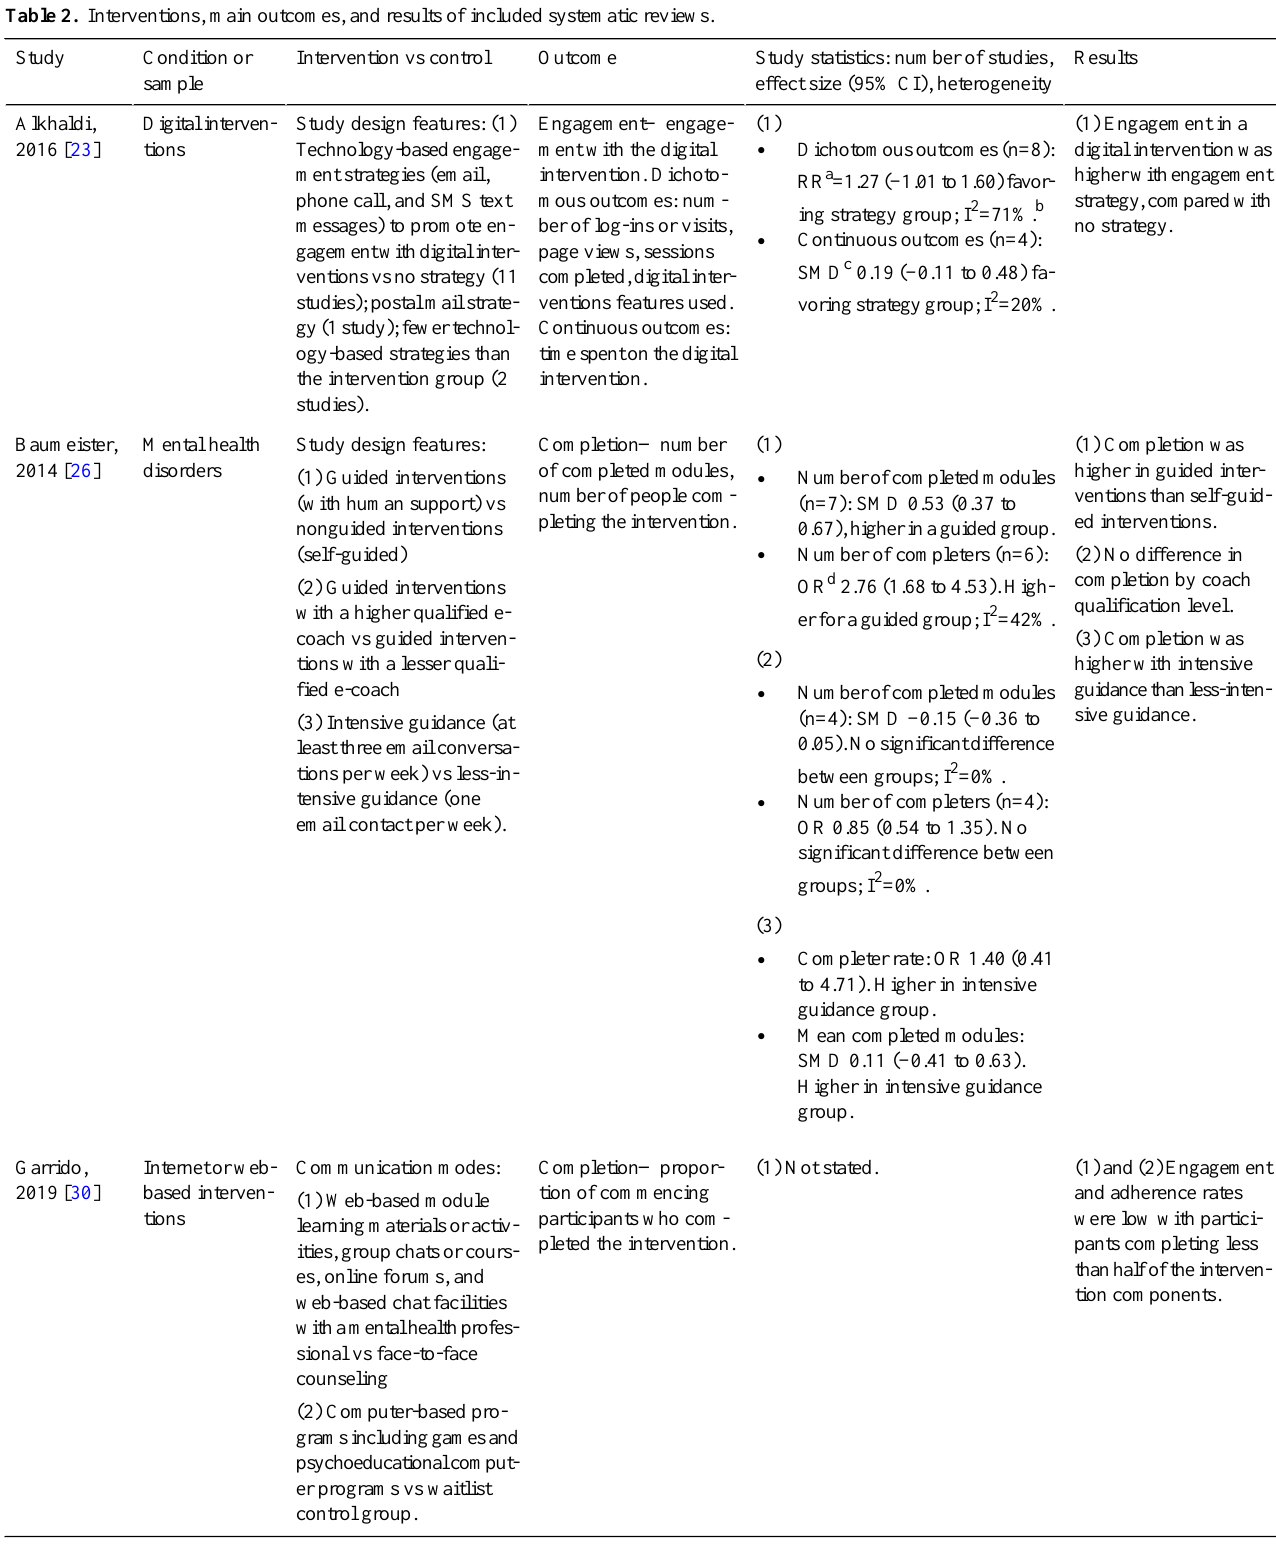
Table 2. Interventions, main outcomes, and results of included systematic reviews.